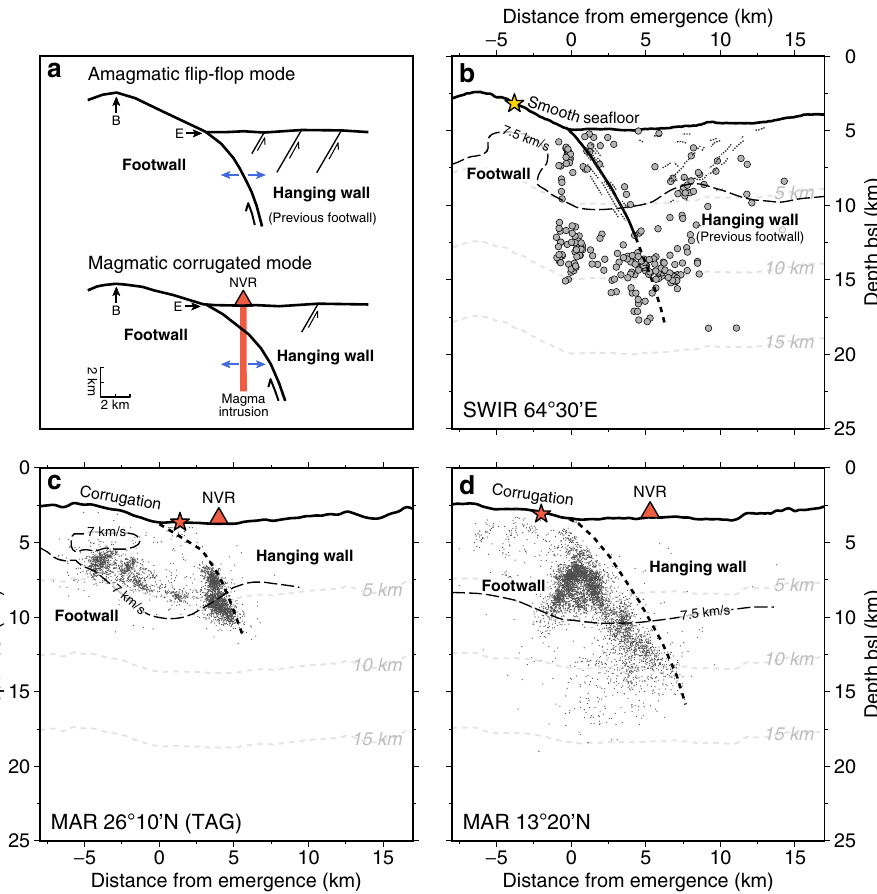
Fig. 3 | Modes of detachment faults and their patterns of seismicity. a 2D conceptual sketch of amagmatic fl ip – fl op and magmatic corrugated modes of detachment faults. The fl ip- fl op mode may have more hanging-wall faults to accommodate part of the plate spreading, while this part of plate spreading at the corrugated mode is accommodated by magma intrusions. b – d Microseismicity at